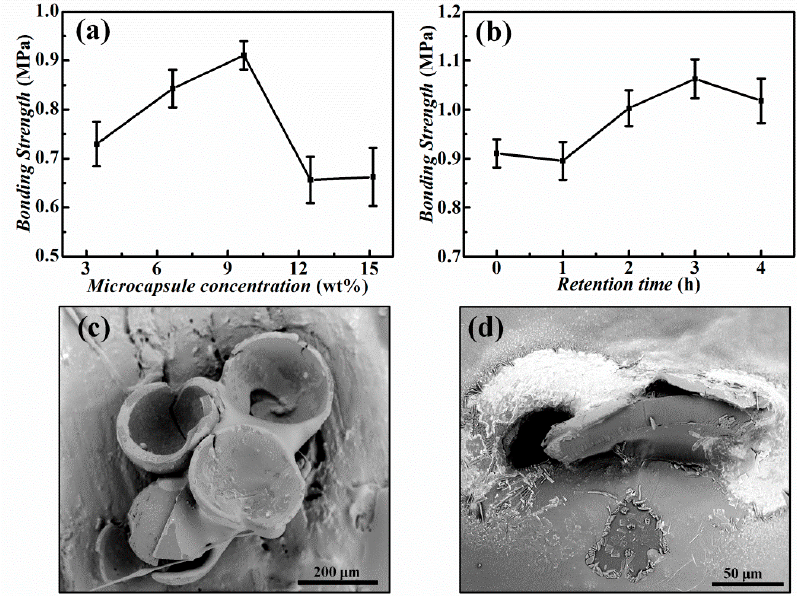
Figure 7. ( a ) Bonding strength of the wood boards versus the concentration of microcapsules in pressure-sensitive adhesive (PSA) mixture. ( b ) Bonding strength of the wood boards versus the retention time of the PSA containing 9.68 wt% microcapsules. ( c ) SEM image of ruptured microcapsules in PSA after polymerization. ( d ) SEM image of a ruptured capsule wrapped in the PSA.